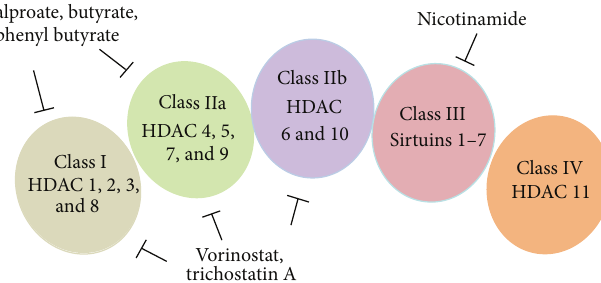
Figure 2: Classification of histone deacetylase families. HDACs: histone